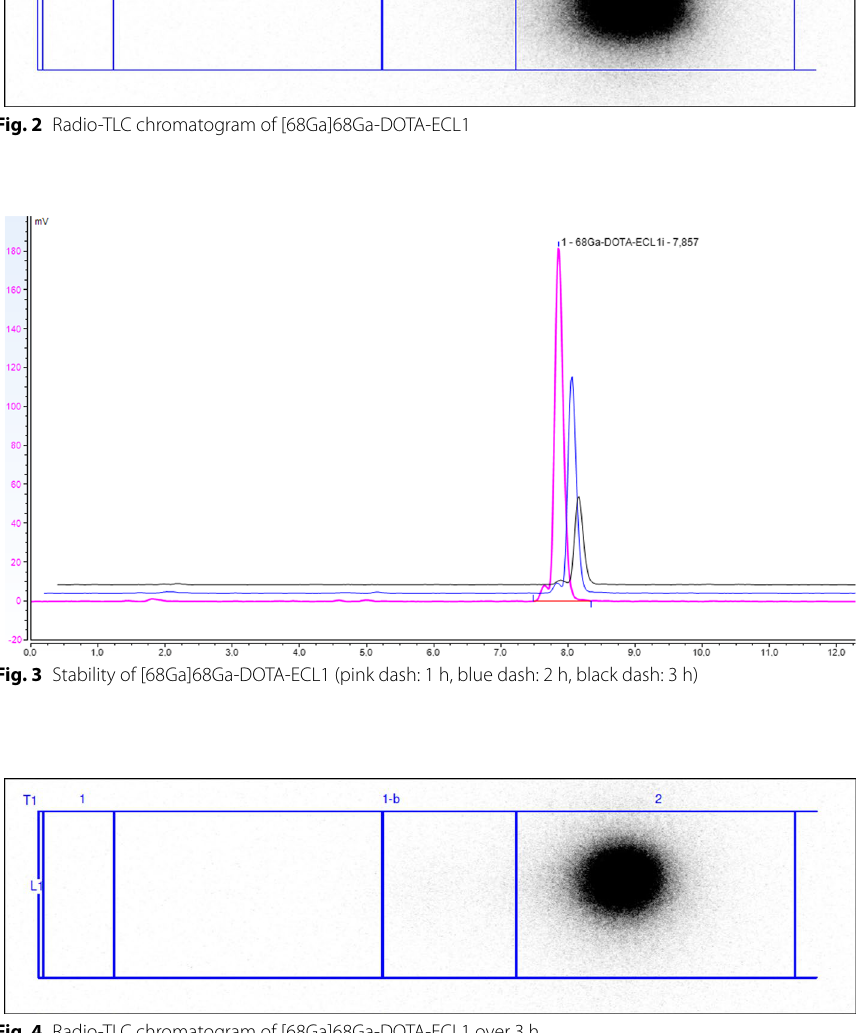
Fig. 4 Radio-TLC chromatogram of [68Ga]68Ga-DOTA-ECL1 over 3